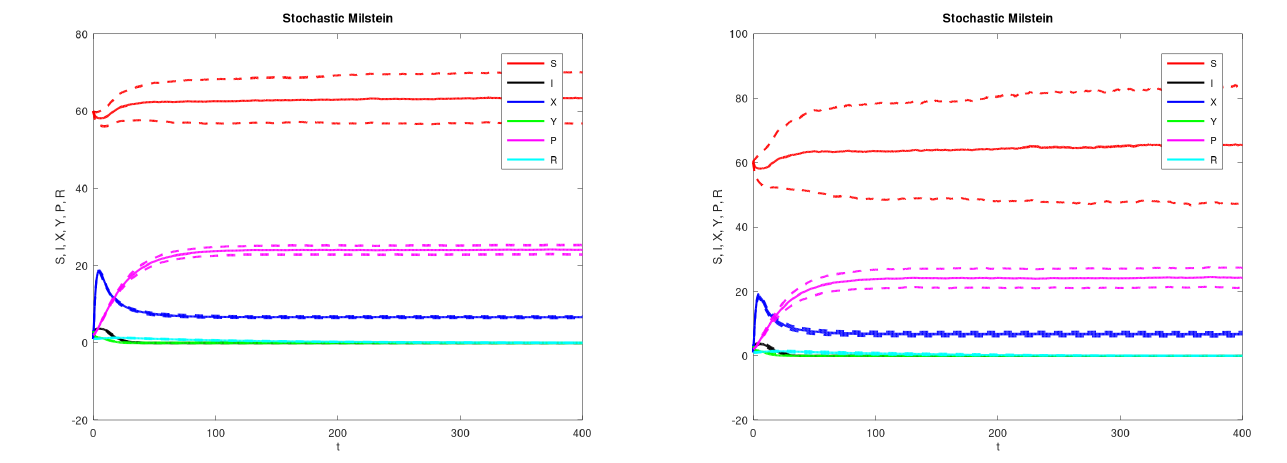
Figure 4. Plots for the plant-virus model with mass action interactions and no delays using the stochastic differential equations model. The solid lines are the mean values, and the dashed lines are the mean value plus or minus one standard deviation. ( Left ) σ s equal to 0.01. ( Right ) σ s equal to 0.025.